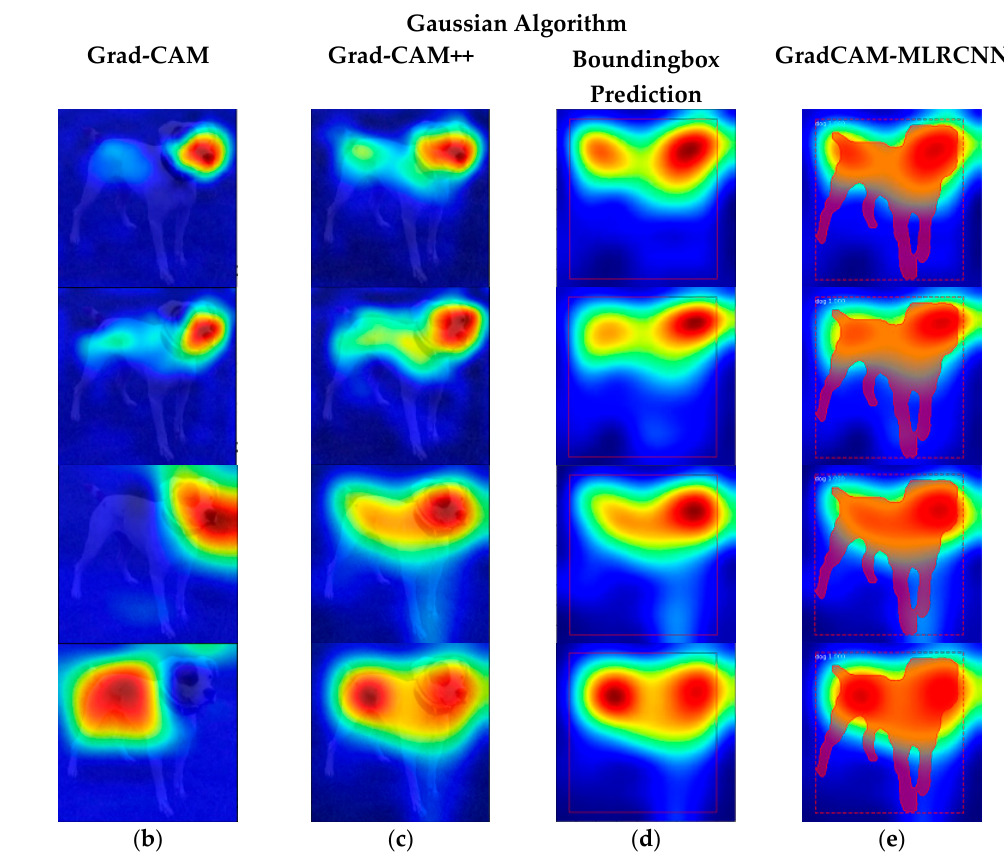
Figure 5. ( a ) Various pre-trained models; ( b ) results of Grad-CAM; ( c ) results of Grad-CAM++; ( d ) bounding box prediction on Grad-CAM++; and ( e ) GradCAM-MLRCNN.